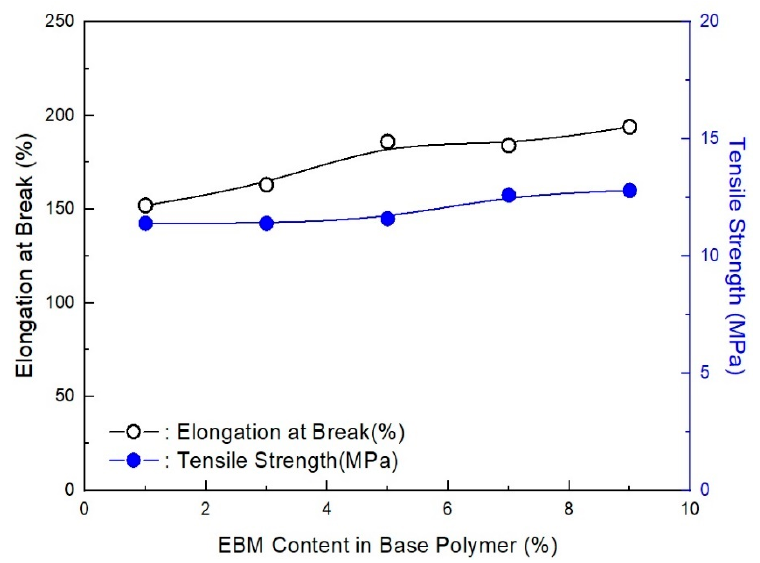
Figure 12. Tensile strength and elongation at break of EVA/EXACT 8201/CLNA ‐ 8400/. 125 phr flame-retardant (MH+ZB+RP) formulations as a function of EBM content.